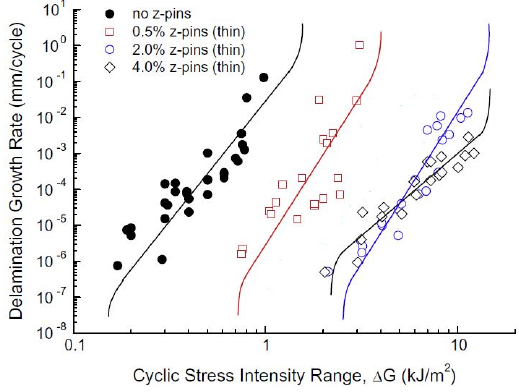
Figure 54. E ff ect of z-Pin content in Paris curves for mode I z-Pinned laminate (CFRP z-Pins, d = 0.28 mm, l = 4 mm, [0 n [0 / 90]] s pre-preg) [33].